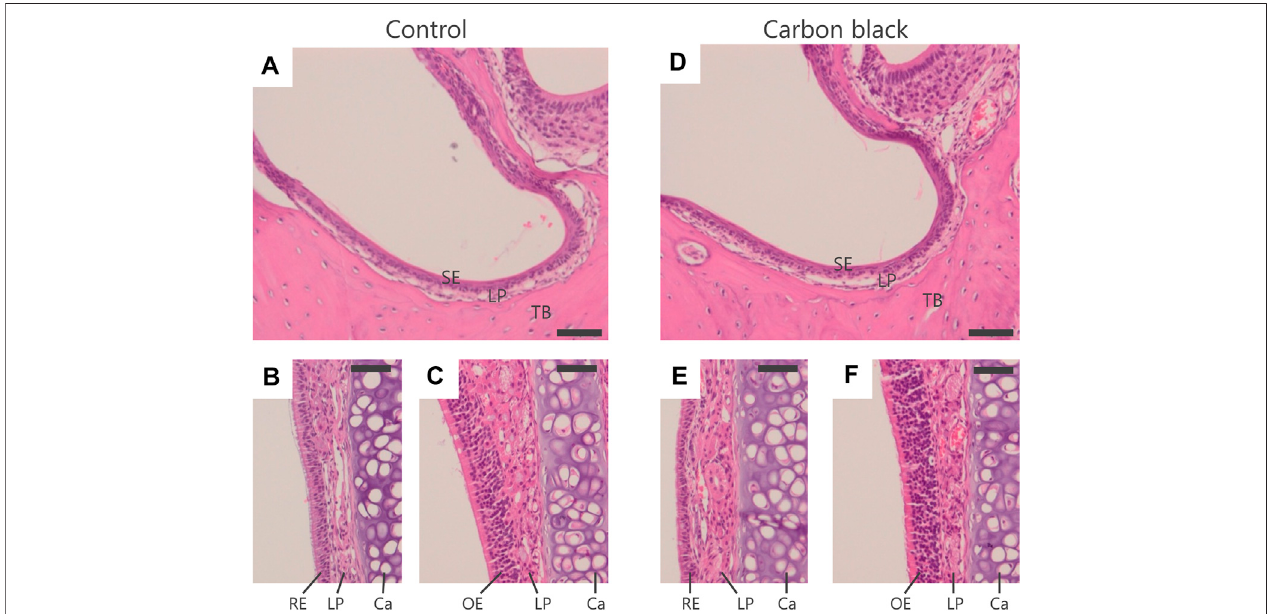
FIGURE 3 | Histological analysis of nasal cavity of mother mice. (A – C) : Control group. (D – F) : CB-NP-exposed group. (A,D) : Nasal vestibule region. (B,E) : Respiratory region. (C,F) : Olfactory region. The scale bars represent 50 mm. Paraf fi n sections (4 μ m) of the nasal cavity of mother mice ( n (cid:2) 5) were stained with hematoxylin and eosin after 10-days of fi nal instillation. Deposition of CB-NP and histopathological alteration was not detected in the nasal cavity and/or surrounding regions of mother mice. Abbreviations: RE; Respiratory Epithelium, LP; Lamina Propria, Ca; Cartilage, OE; Olfactory Epithelium, SE; Squamous Epithelium, TB; Turbinate Bones.